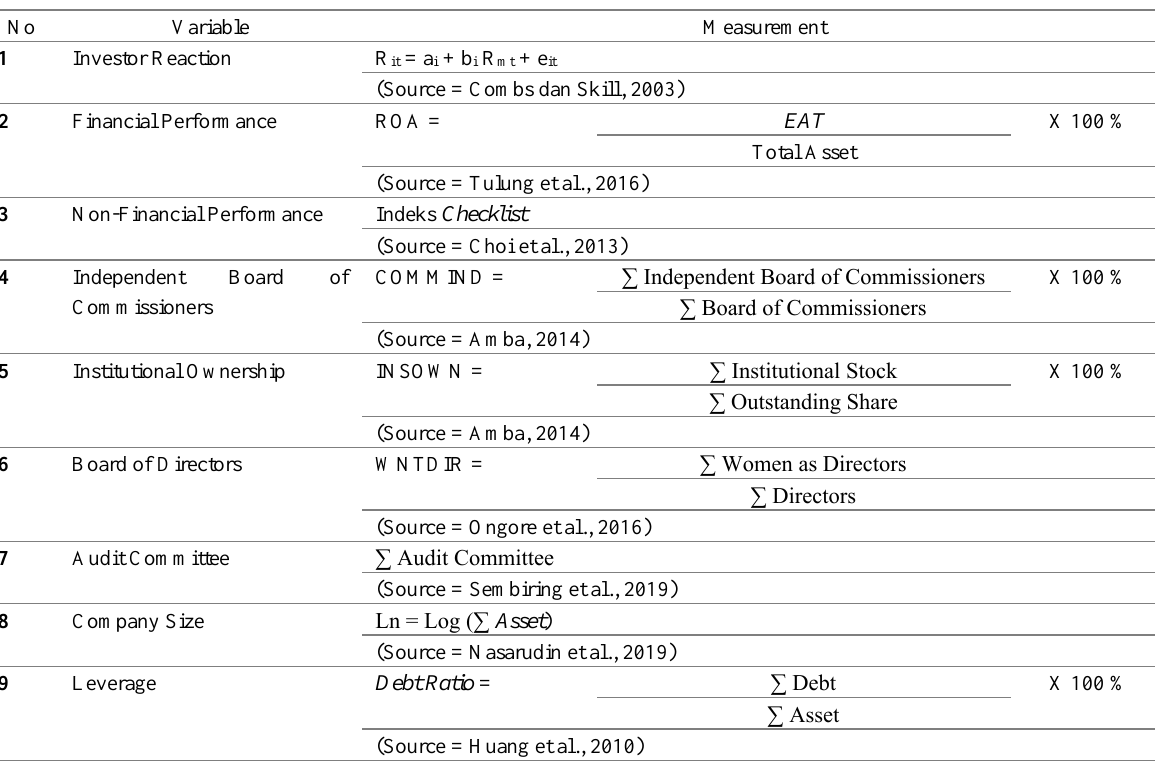
Table 2: Operationalization of